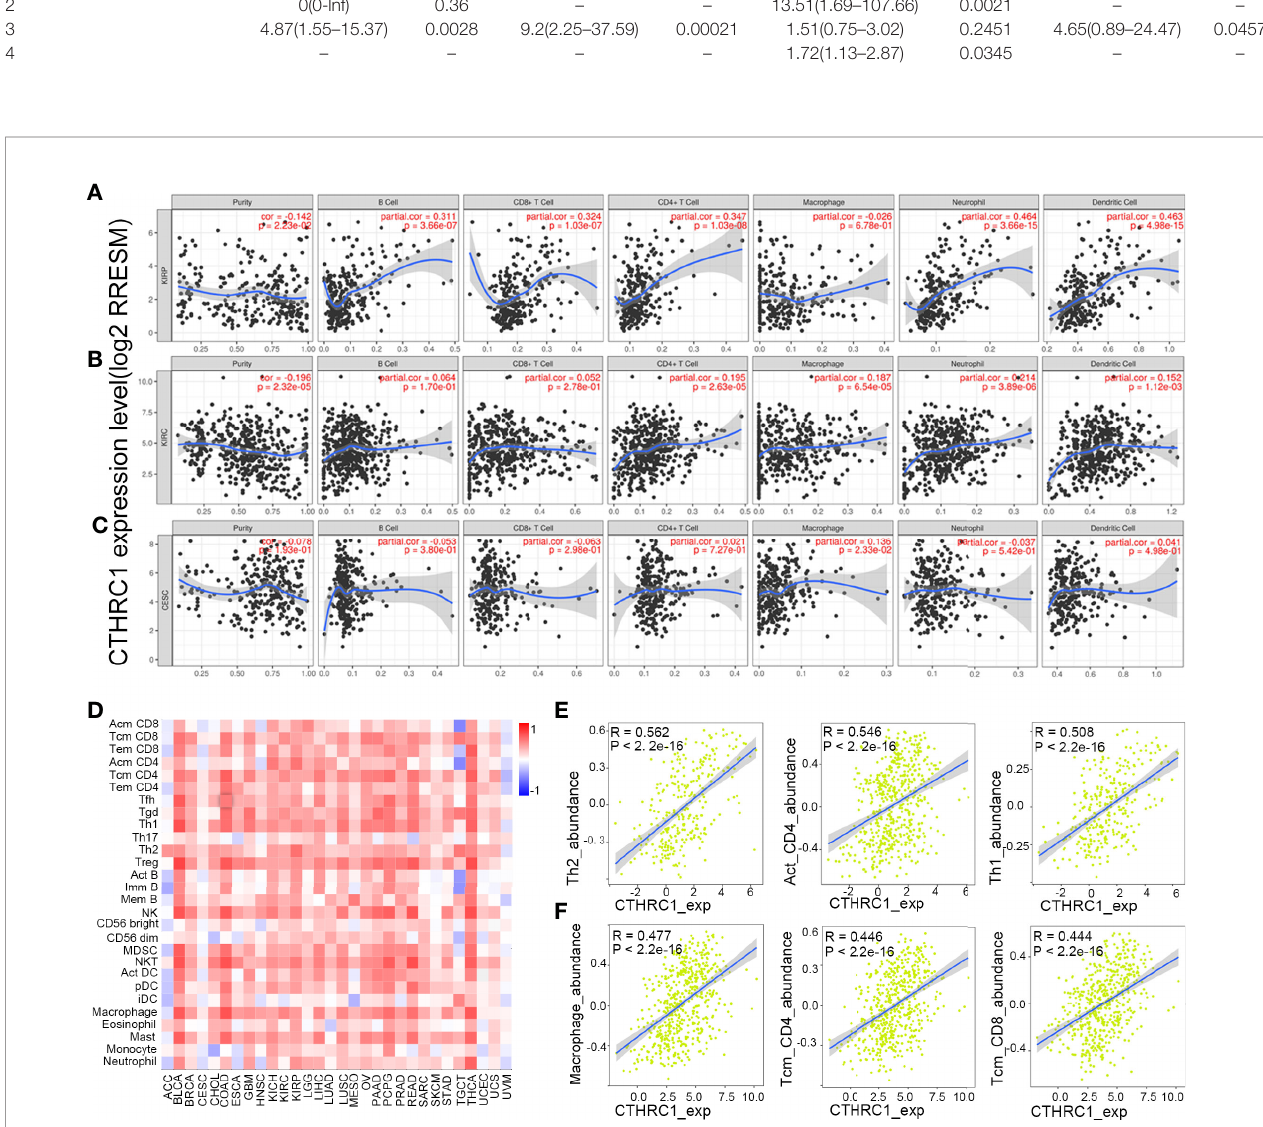
FIGURE 4 | Correlation analysis of CTHRC1 level and immune cells in fi ltration levels across human cancers using the TIMER database and TISIDB database. (A) CTHRC1 expression in KIRP tissues positive correlates with tumor immune in fi ltration levels of B cells, CD8 + T cells, CD4 + T cells, neutrophils, and dendritic cells. (B) CTHRC1 level correlates with tumor immune in fi ltration in KIRC. (C) CTHRC1 level weakly correlated with immune cells in fi ltration of CESC. (D) Relations between expression of CTHRC1 and 28 types of TILs across human heterogeneous cancers. (E) Top 3 TILs were displaying the greatest Spearman ’ s correlation with CTHRC1 expression in KIRP. (F) CTHRC1 signi fi cantly correlated with abundance of top 3 TILs in KIRC.